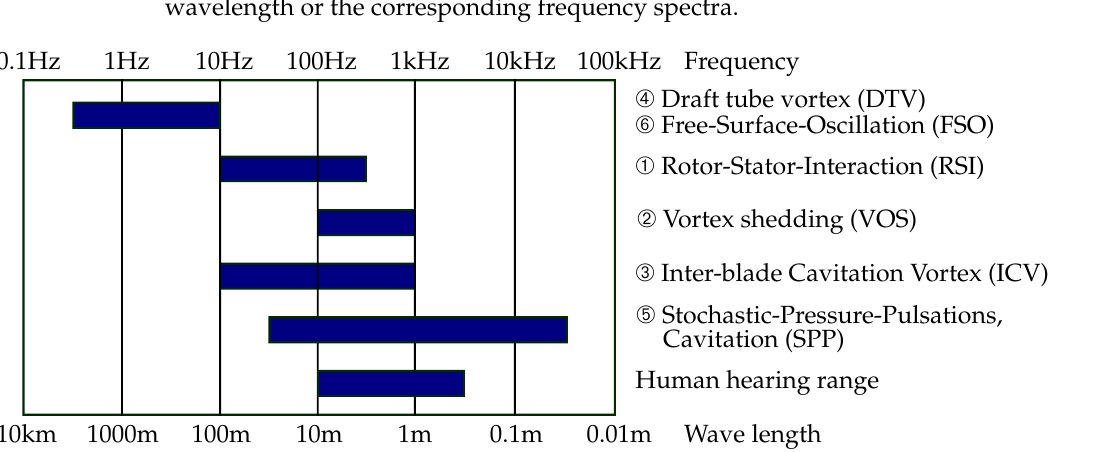
Figure 8. Overview of the frequencies observed in a Francis turbine. Figure adapted from [35].